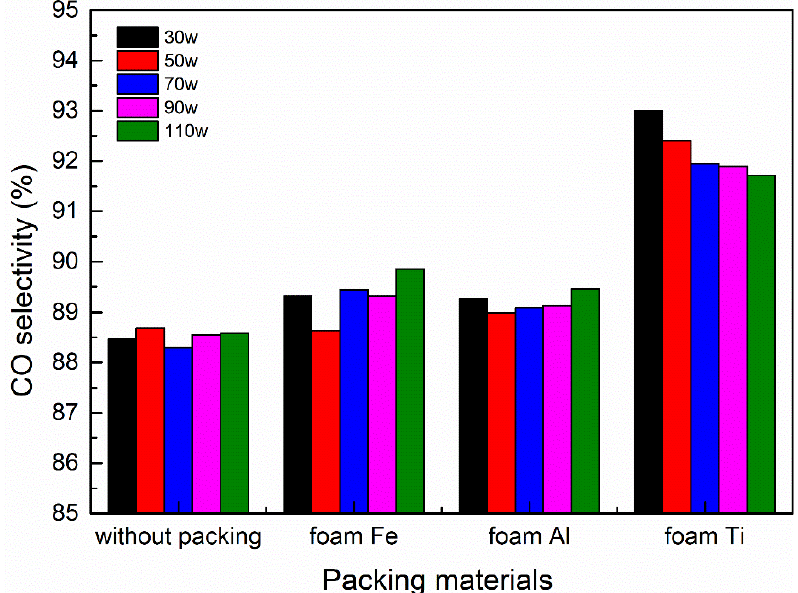
Figure 10. CO selectivity of different foam metals at different discharge powers.